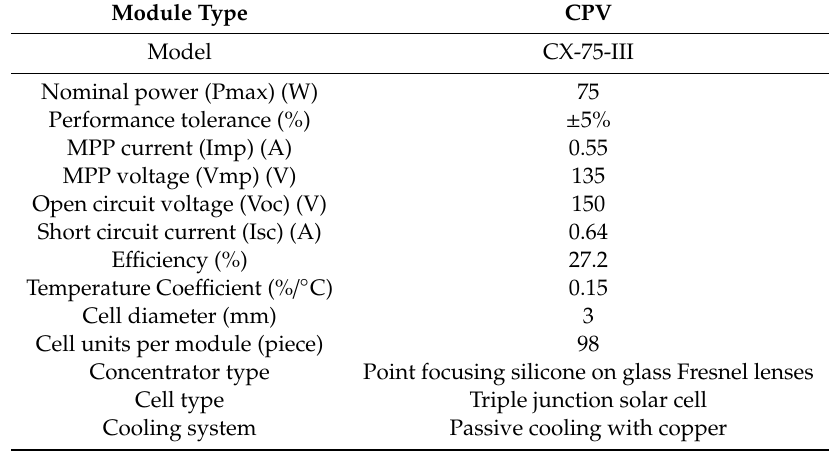
Table 1. Technical specifications of the concentrator photovoltaic (CPV) module. (standard test conditions: